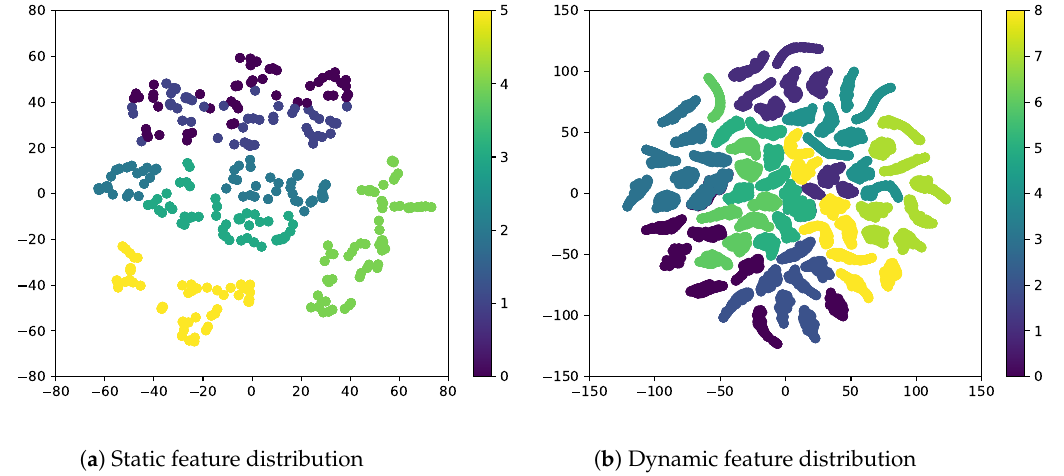
Figure 3. Ours: visualization of ( a ) static and ( b ) dynamic features in the latent spaces on the Sprites dataset using t-SNE [27]. The static and dynamic features are separately distributed for each